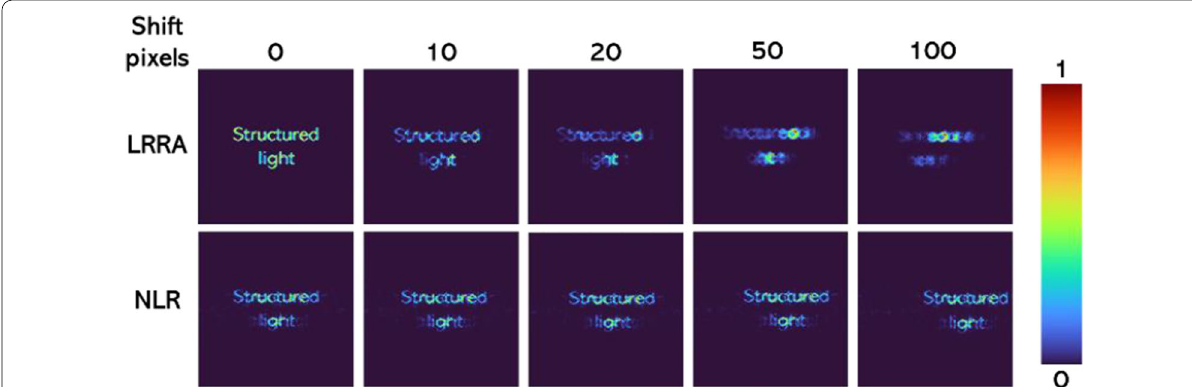
Fig. 7 Reconstruction results using LRRA and NLR during a shift error of 0, 10, 20, 50 and 100